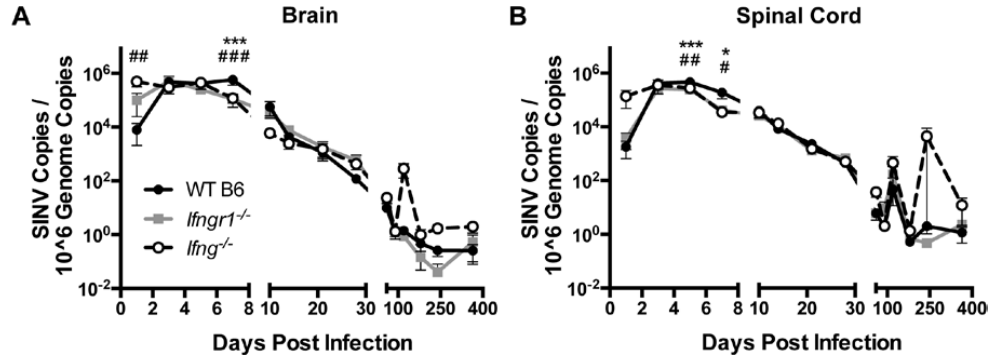
Figure 5. Effect of IFN- γ signaling on viral RNA clearance in vivo. Viral RNA levels were examined by qRT-PCR in brains ( A ) and spinal cords ( B ) of WT (black circle and solid line), Ifngr1 −/− (gray square and solid line), and Ifng − / − (white circle and black dashed line) mice ( n = 3–8 mice per strain per time point; data are presented as the mean ± SEM; * p < 0.05, *** p < 0.001, WT vs. Ifngr1 −/− ; # p < 0.05, ## p < 0.01, ### p < 0.001, and WT vs. Ifng −/− , all by Tukey’s multiple comparisons test).